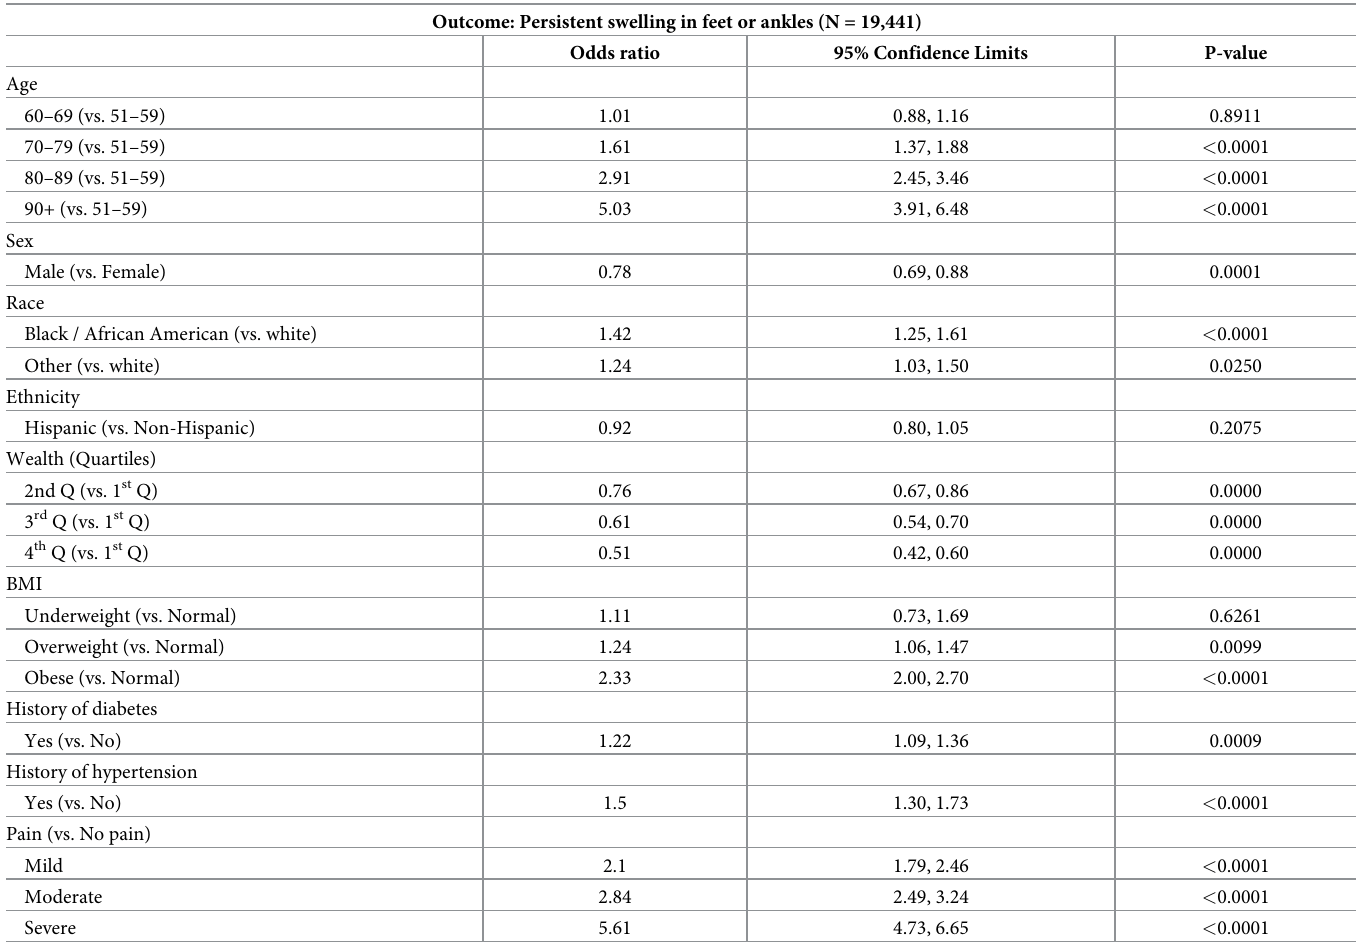
Table 2. Results of a weighted multivariable logistic regression of peripheral edema on demographic and clinical variables (age 51+, 2016 HRS